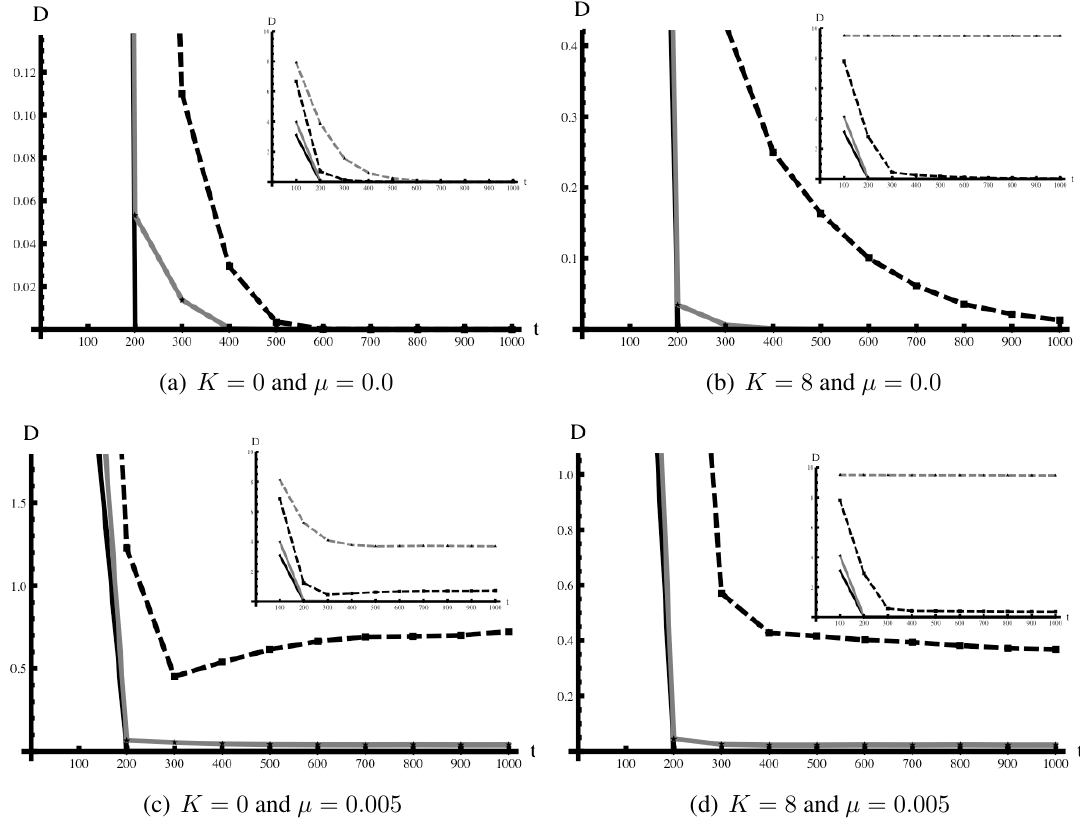
Figure 4. The diversity within an organization for two levels of complexity, K = 0 ( left ) and K = 8 ( right ), and two degrees of environmental turbulence, µ = 0 . 0 ( top ) and µ = 0 . 005 ( bottom ). The communication is active ( p = 1 . 0 ). Four values of λ are considered: λ = 0 . 0 (solid black), λ = 0 . 2 (solid gray), λ = 0 . 6 (dashed black), λ = 1 . 0 (dashed gray). For clarity of exposition, only λ ∈ { 0 . 0 , 0 . 2 , 0 . 6 } are shown in the main figure. See the insets for all four λ s. The extent of diversity is measured based on the discrepancy between individual configurations and their means. The data is generated by taking the average per-period diversity for each block of 100 periods. The average from 500 simulation runs is